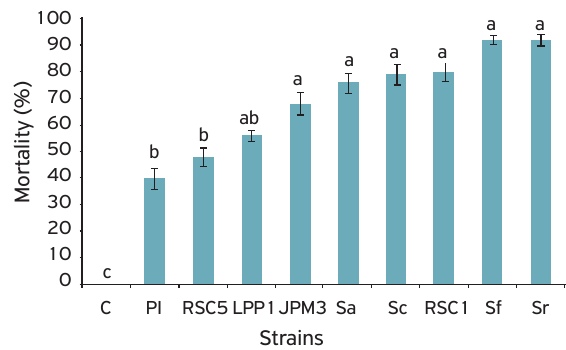
Figure 1. Mortality ± standard error caused by strains of entomopathogenic nematodes to Mahanarva spectabilis nymphs at a concentration of 2,000 IJs/mL under laboratory